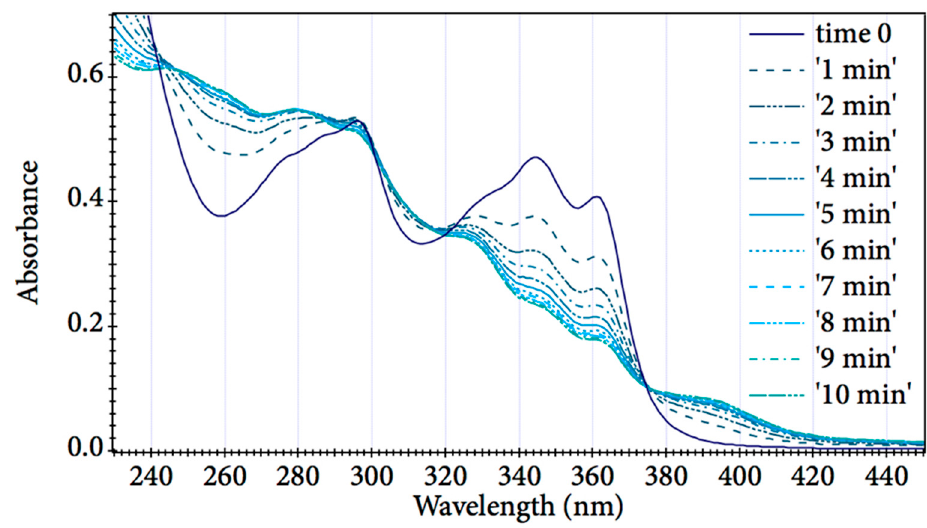
Figure 2. Photoconversion of 1 (2 × 10 − 5 M) with NADH (4 × 10 − 5 M) and FMN (1 × 10 − 6 M) in PB (5 × 10 − 2 M, pH = 7.0); λ = 460 nm.